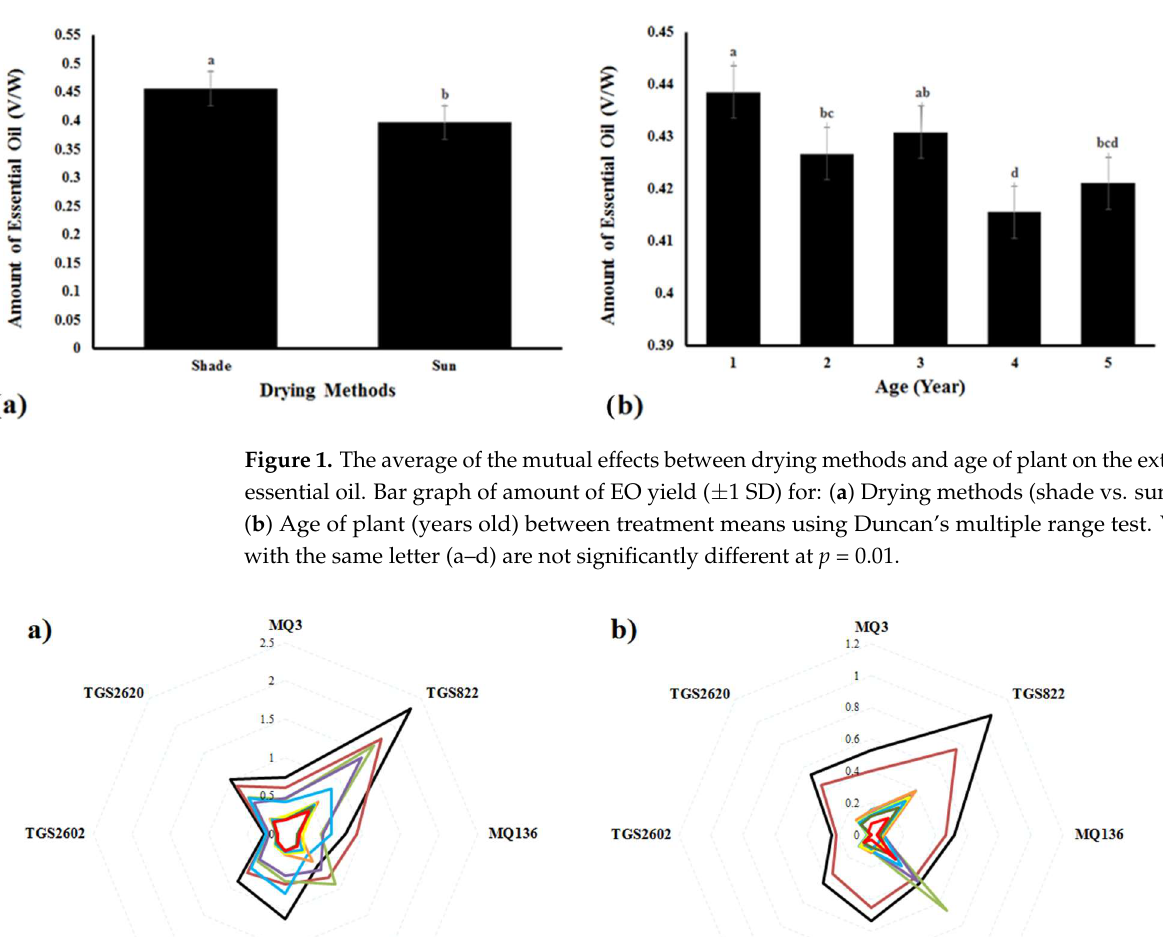
Figure 1. The average of the mutual effects between drying methods and age of plant on the ex- tracted essential oil. Bar graph of amount of EO yield (±1 SD) for: ( a ) Drying methods (shade vs. sun), and ( b ) Age of plant (years old) between treatment means using Duncan’s multiple range test. Values with the same letter (a–d) are not significantly different at p = 0.01.